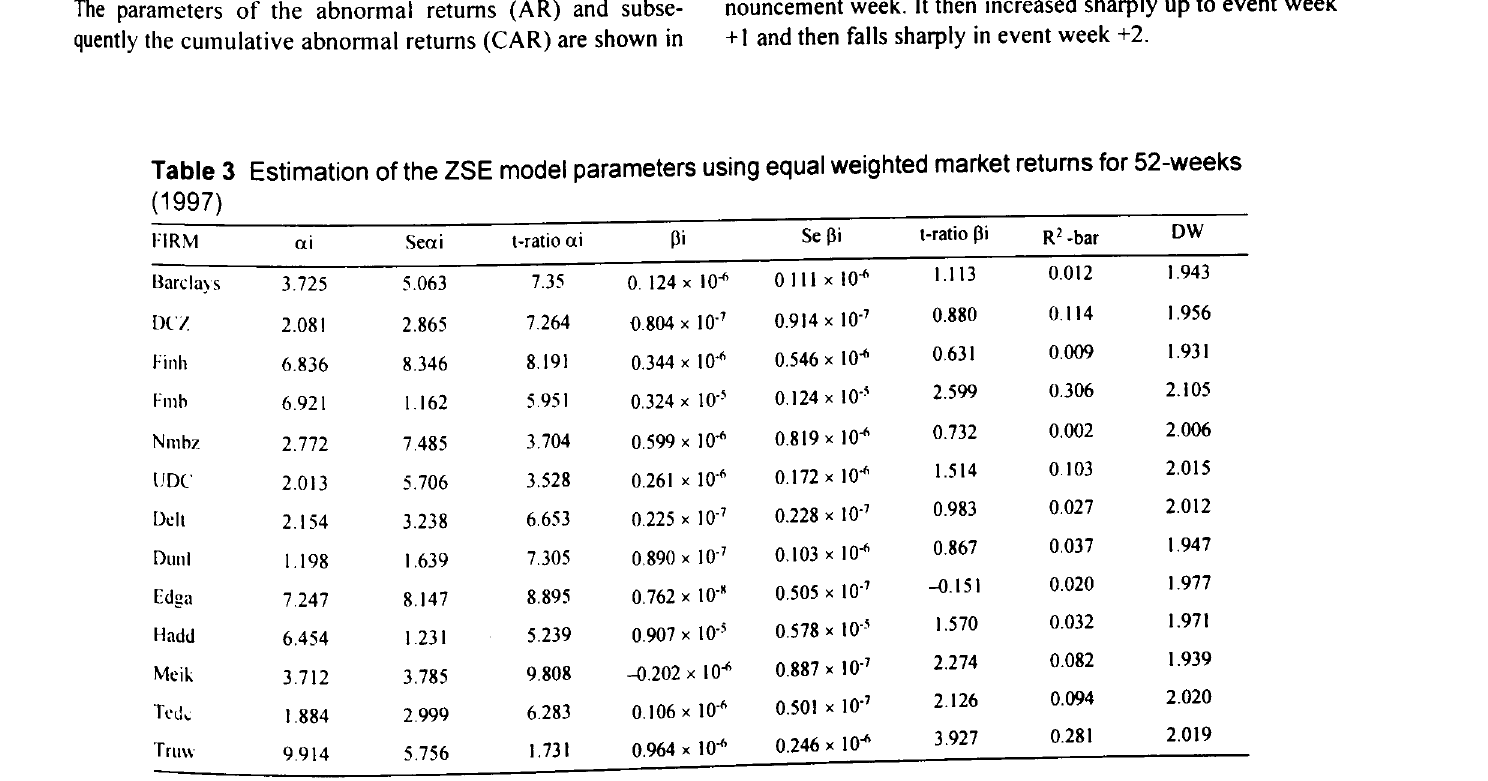
Figure I CAR plot for the BSE